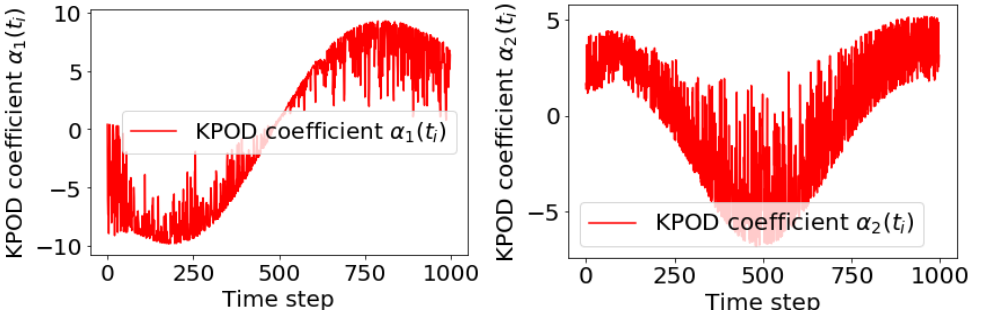
Figure 4. KPOD orthogonal coefficients α 1 ( t i ) ( left ) and α 2 ( t i ) ( right ), with respect to the time step i = 1, . . . , M